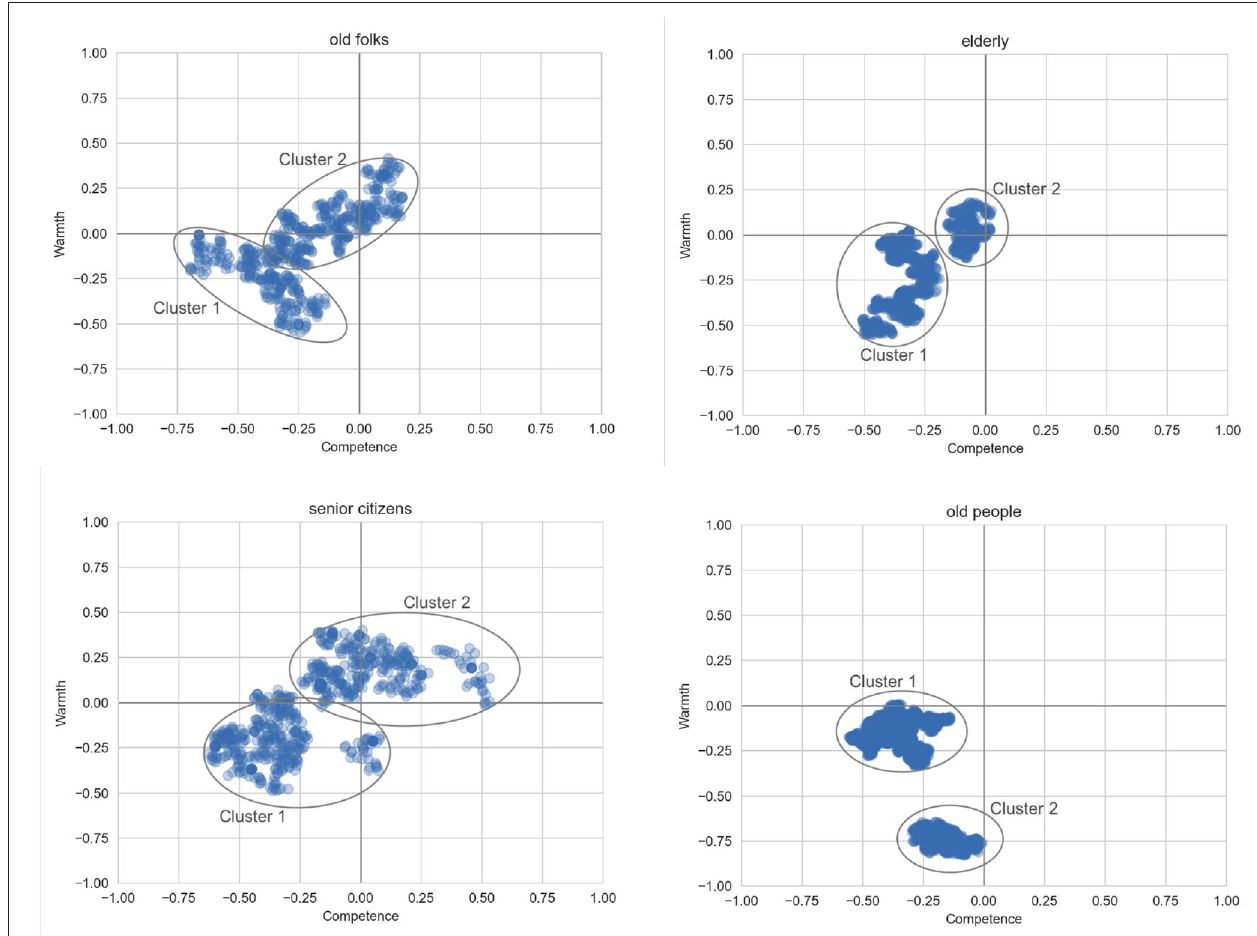
FIGURE 5 | Areas of highest density for the different labels for older